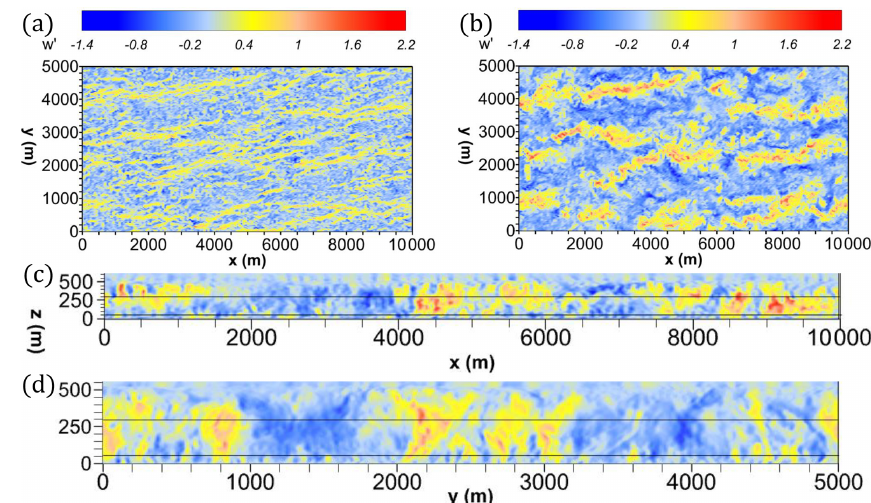
Figure 4. Image of instantaneous vertical velocity contours for an x – y top-down view (a, b) , x – z streamwise side view (c) , and y – z spanwise side view (d) . The x – y top-down views are in panel (a) z/z inv = 0 . 083 (or 50m) and in panel (b) z/z inv = 0 . 525 (or 300m). x is the streamwise direction of the flow. The solid black lines across (c, d) are the heights of panel (a) and panel (b) plane visualizations.